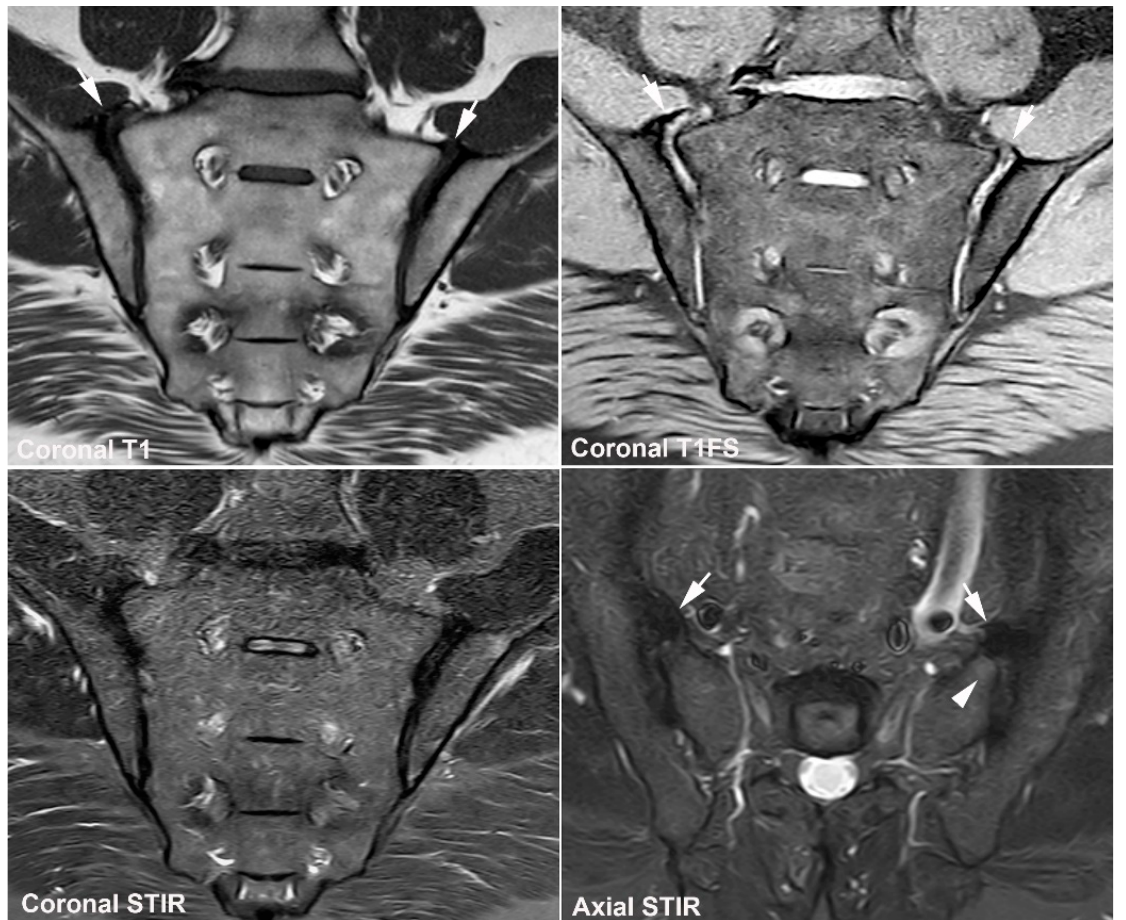
Figure 20. Diffuse idiopathic skeletal hyperostosis (DISH). MRI in a 64-year-old man presenting with flowing thoracic paravertebral ossification conforming to DISH, semi-coronal T1, T1FS, and STIR, and semi-axial STIR images of the SIJ showing periarticular new bone formation superiorly and anteriorly at the joints (arrows) in addition to a slight subchondral BME in the sacrum on the left side (arrowhead), but no manifest BME or